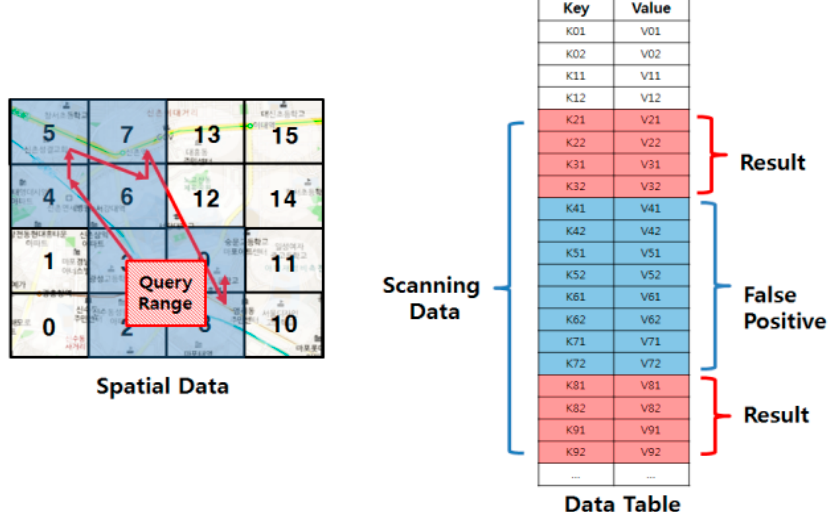
Figure 1. Range query processing using a linearization technique.